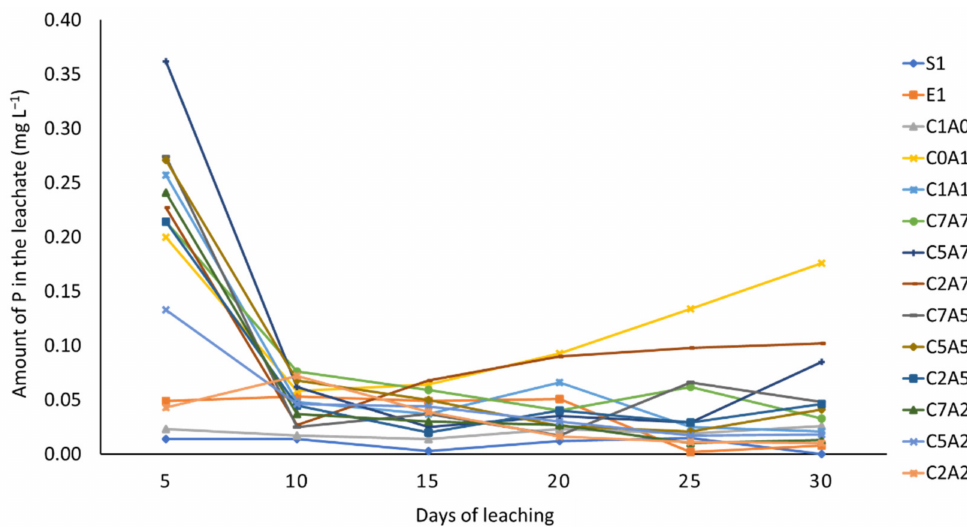
Figure 4. Treatments on phosphorus availability in leachate over thirty days of leaching, where S1: soil only; E1: soil with ERP only; C1: 100% charcoal; C0: 0% charcoal; C7: 75% charcoal; C5: 50% charcoal; C2: 25% charcoal; A1: 100% sago bark ash; A0: 0% sago bark ash; A7: 75% sago bark ash; A5: 50% sago bark ash; A2: 25% sago bark